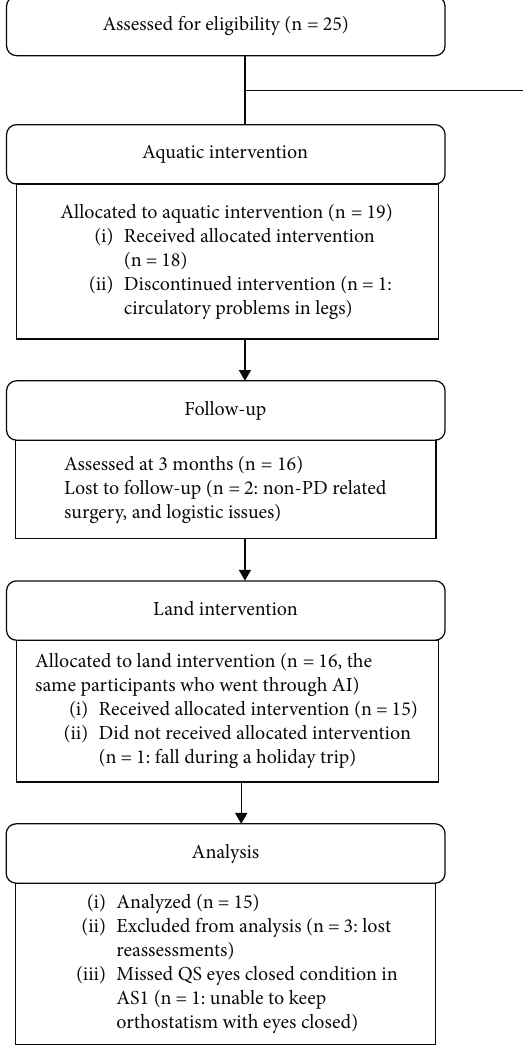
Figure 2: Participant fl ow